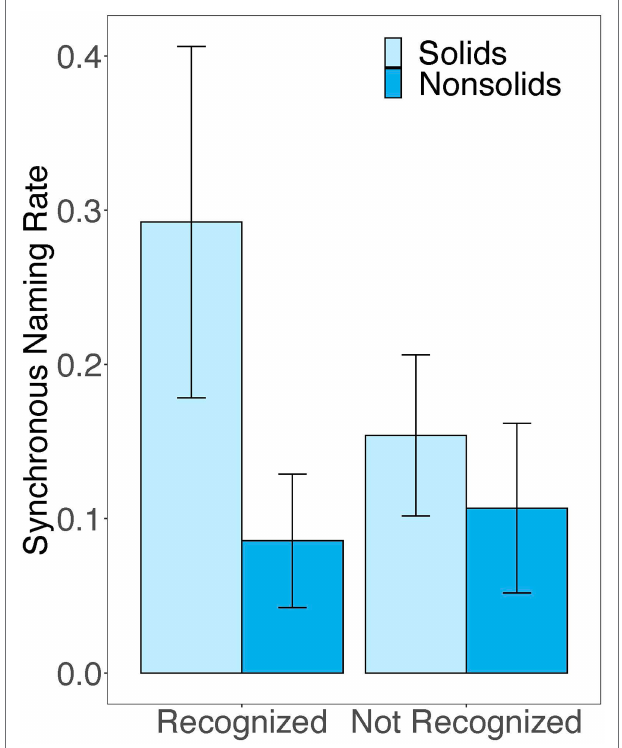
FIGURE 5 | Comparison of synchronous naming during free-play for those novel names that children correctly recognized at test versus those that they did not. Error bars represent standard error of